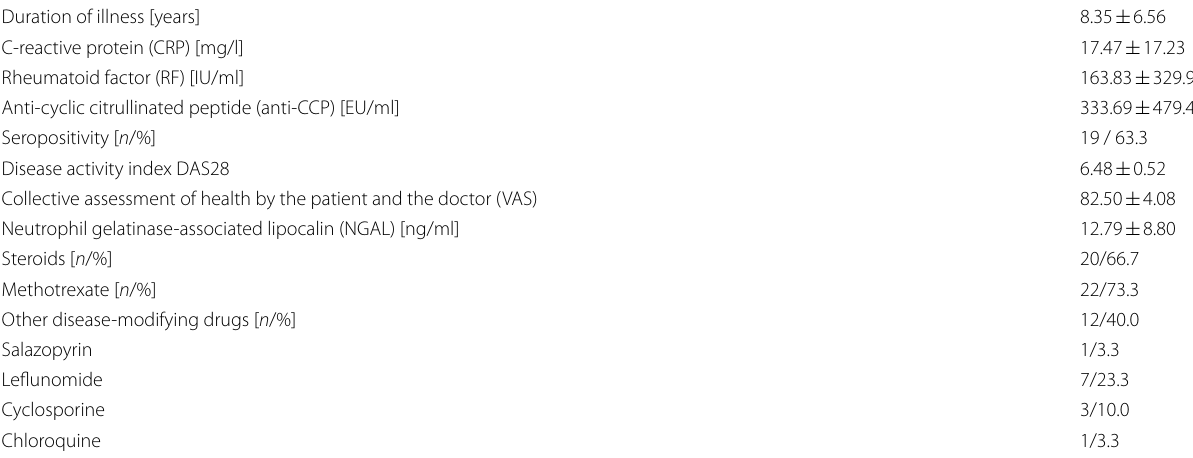
Table 2 Selected clinical parameters in the group of patients with rheumatoid arthritis